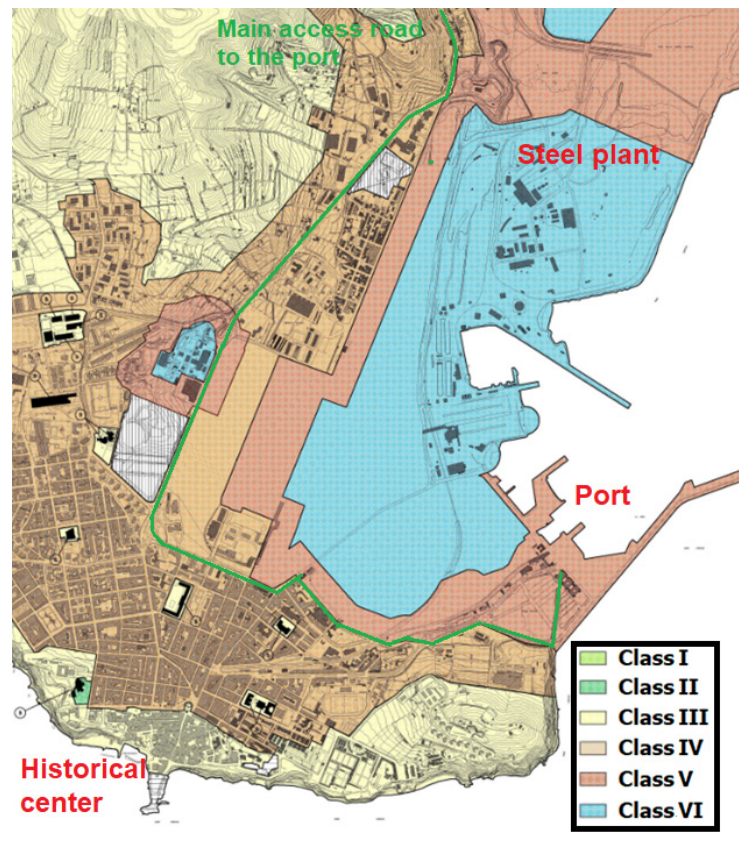
Figure 7. Acoustic territorial zoning of Piombino.